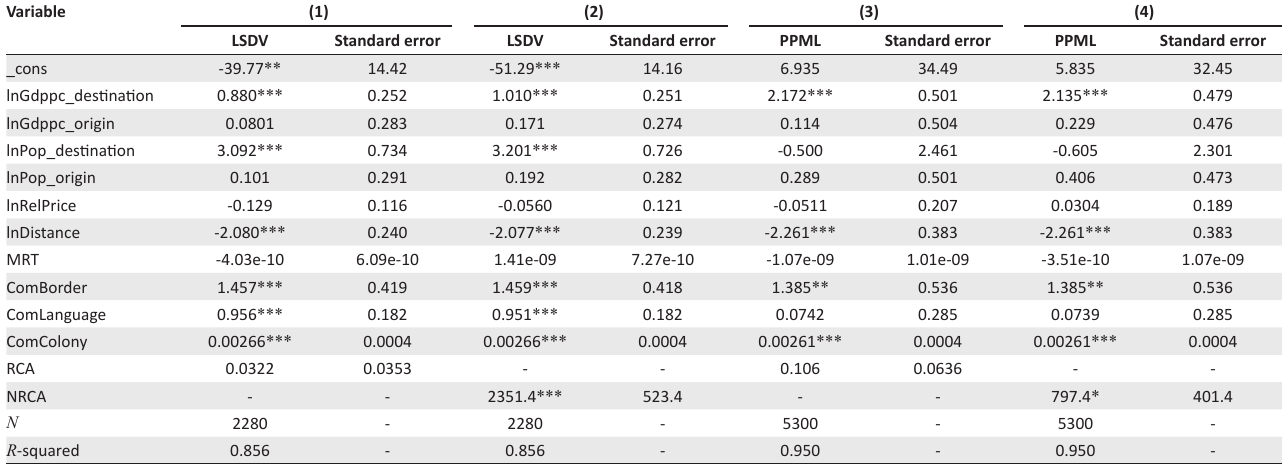
TABLE 3: Revealed comparative advantage results.